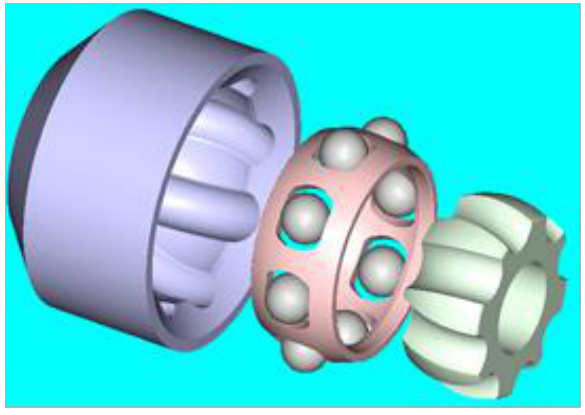
Figure 7. Picture of a bowl-balls joint.